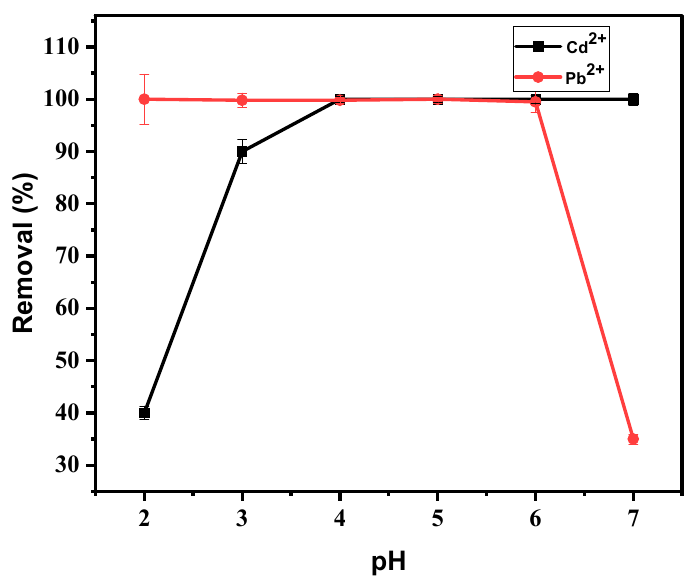
Figure 6. Effect of pH on the adsorption of Cd 2+ and Pb 2+ using BPAC@Al 2 O 3 @chitosan material at a duration of 30 min, the adsorbent mass of 0.1 g, and initial concentration of 20 mg L − 1 .